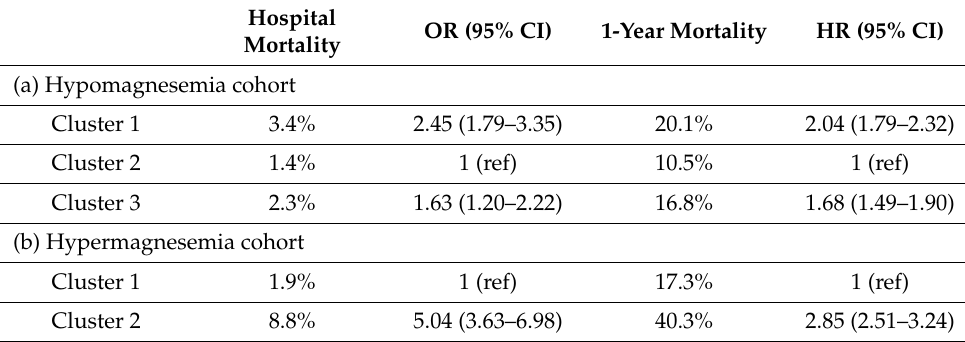
(a) Hypomagnesemia cohort